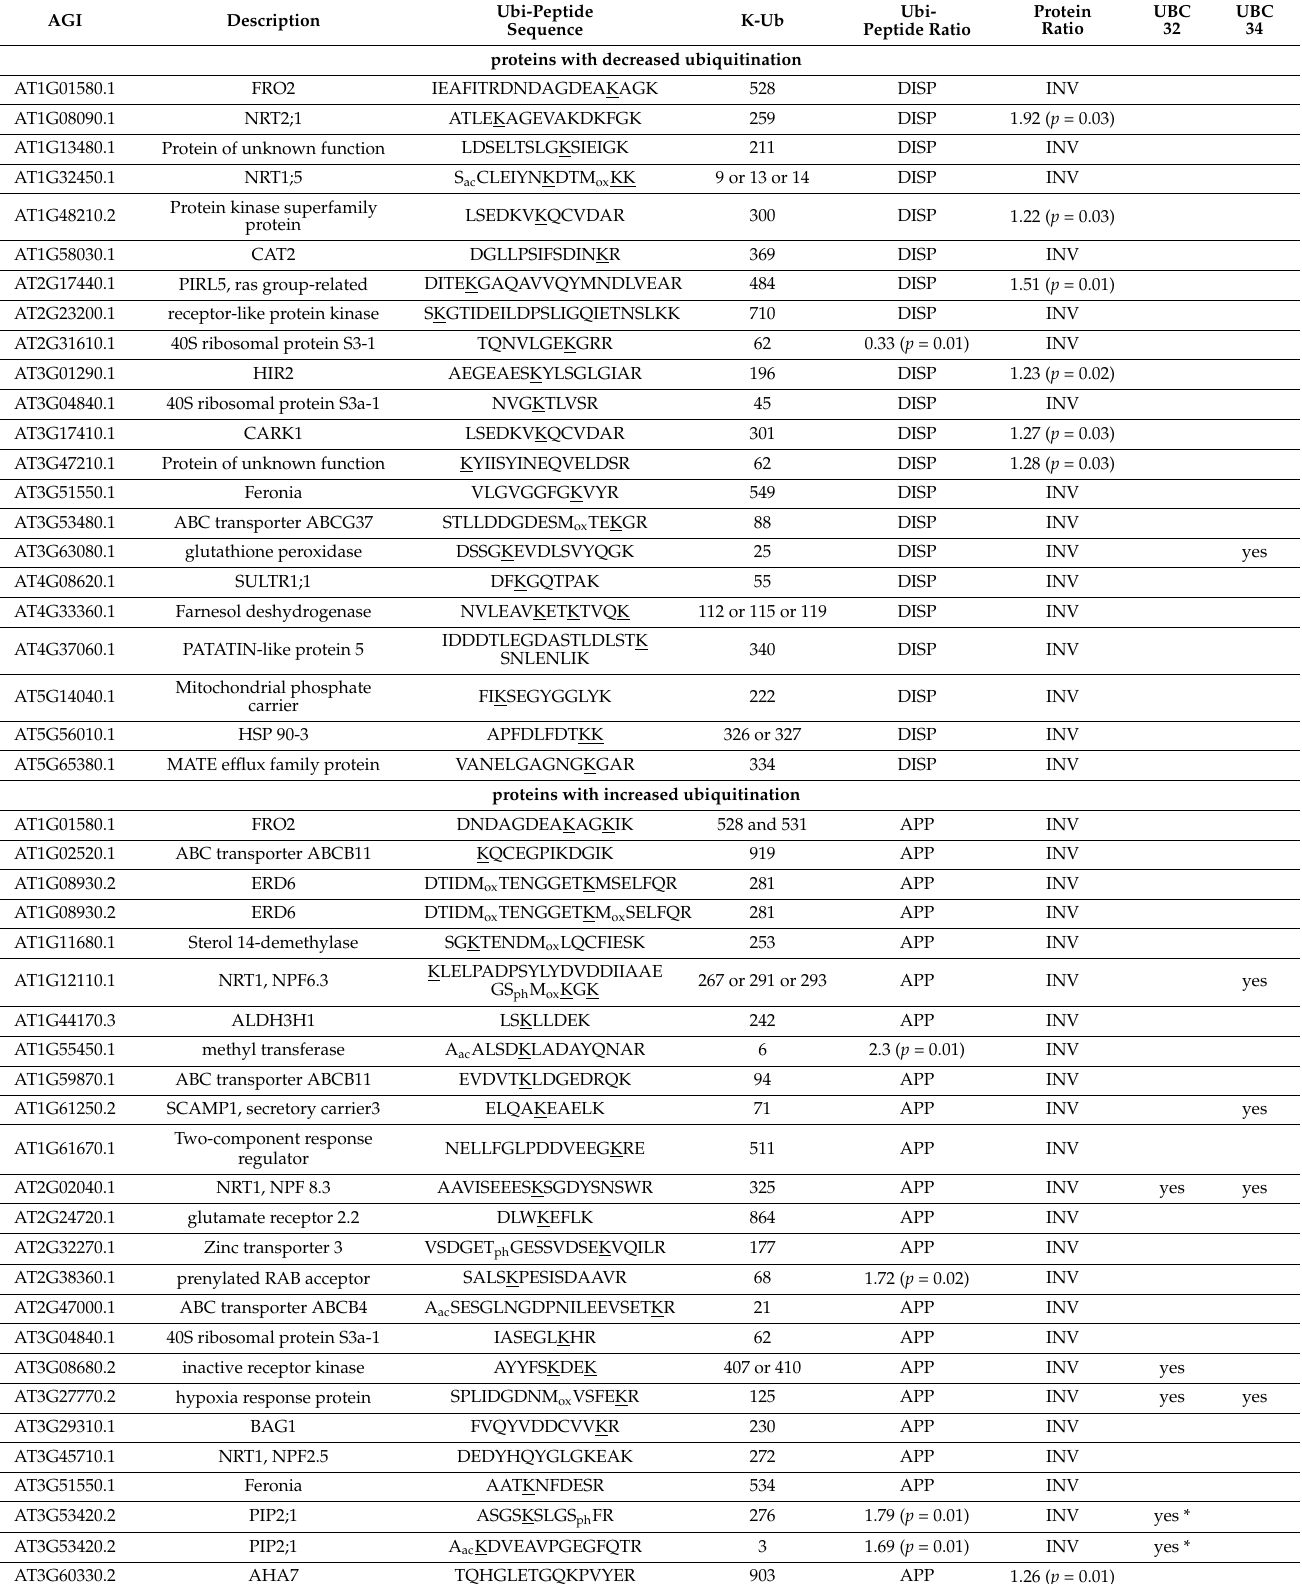
Table 1. Variations in the ubiquitinated peptide and the corresponding protein in response to mannitol